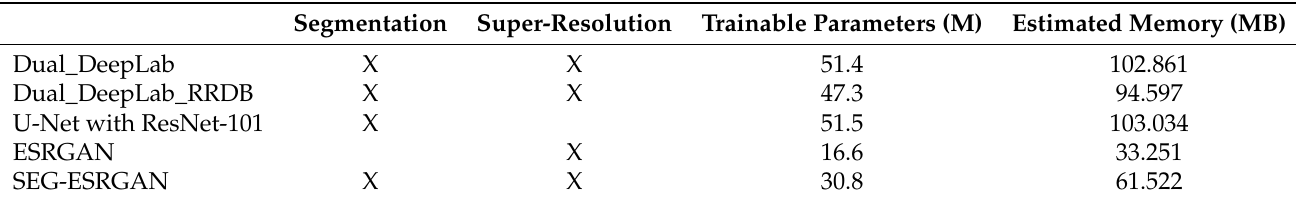
Table 7. Number of parameters and memory consumption of each